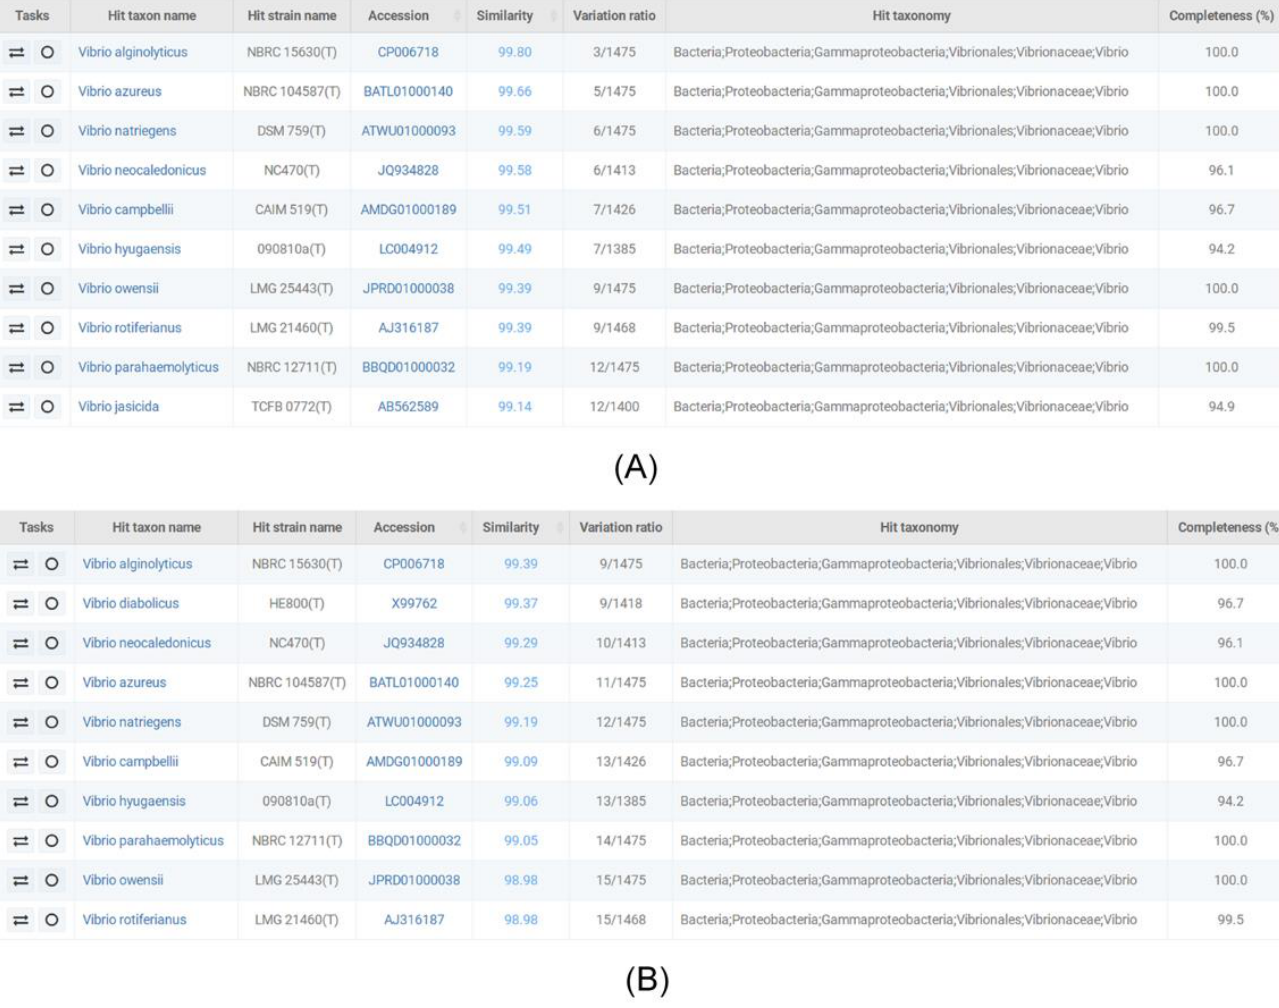
Figure 1. Homology analysis of the 16S rDNA sequences of LHF01 (A ) and LHF02 (B) .